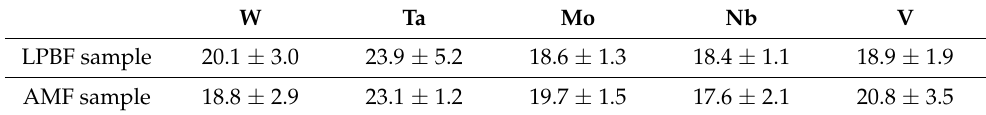
Table 5. Average chemical compositions of samples produced by LPBF and AMF processes.